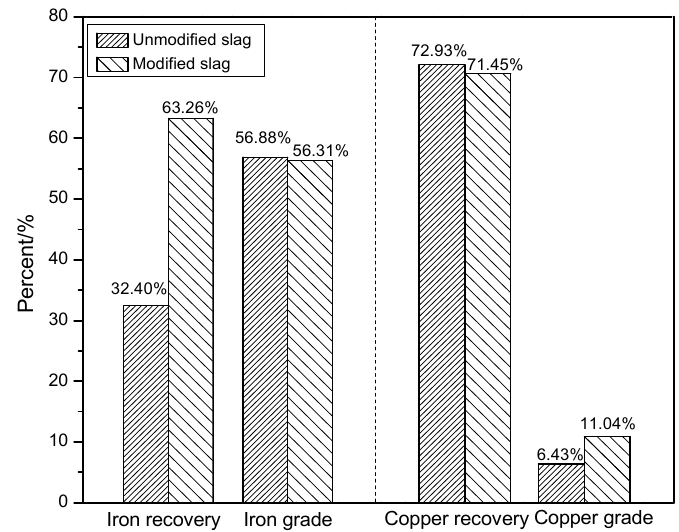
Figure 10. Comparison of beneficiation indexes of copper and iron between two kinds of slags.